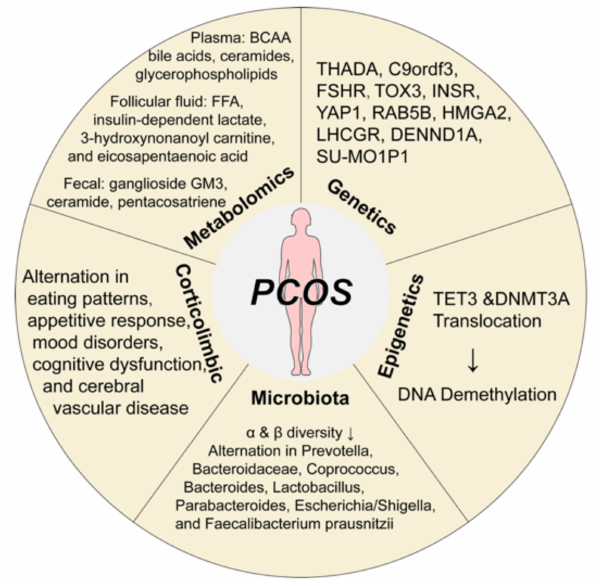
Figure 1. The pathological mechanisms of polycystic ovary syndrome. Great progress has been made in the etiological mechanism of PCOS, including genetics, epigenetics, microbiota, corticol- imbic brain response, and metabolomics. Abbreviations: BCCA, branched-chain amino acid; DNA, Deoxyribonucleic acid; DNMT3A, DNA methyltransferases 3A; FFA, free fatty acid; FSHR, follicle- stimulating hormone receptor; INSR, insulin receptor; PCOS, polycystic ovary syndrome; TET, translocation methylcytosine dioxygenases. Components of this figure were created using Servier Medical Art, provided by Servier, licensed under a Creative Commons Attribution 3.0 unported license